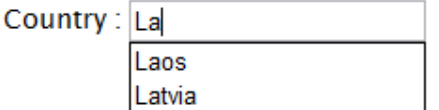
Fig. 6. Automatic filtration of countries by first letters of entered name.